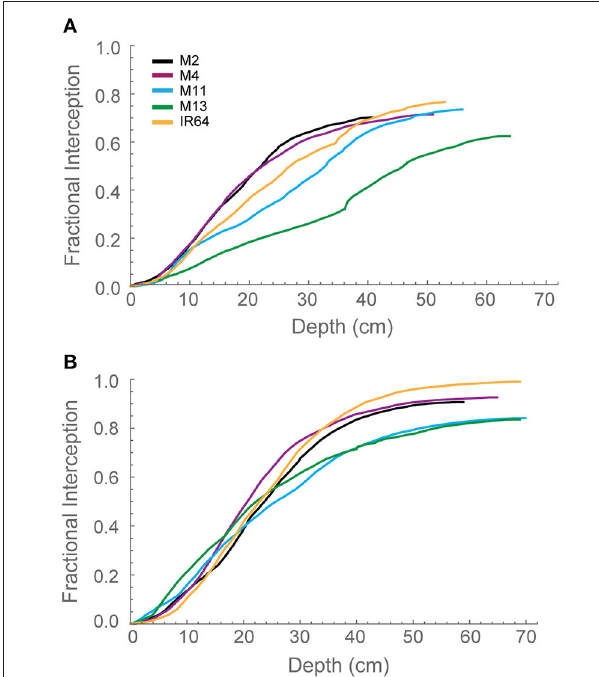
FIGURE 4 | Modeled fractional interception as a function of depth in the canopy at 12:00h for (A) GS1 and (B) GS2, using ray tracing data. Curves were calculated with step ∆ d = 1 mm. M2, M4, M11, and M13 refer to Shan-Huang Zhan-2 (SHZ-2), IR4630-22-2-5-1-3, 157 WAB 56-125, and Inia Tacuari, respectively.